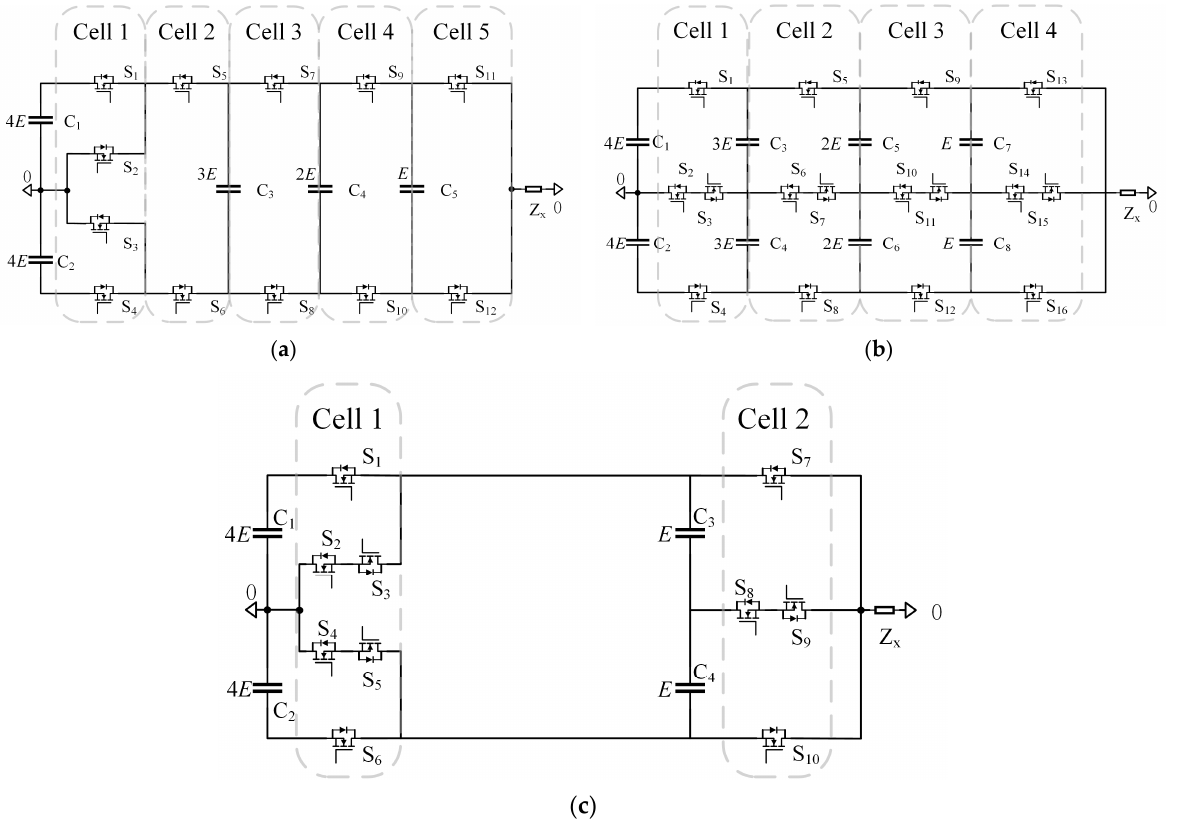
Figure 3. The topology of the three nine-level converters. ( a ) ANPC-9L; ( b ) SMC-9L; ( c ) The proposed topology.